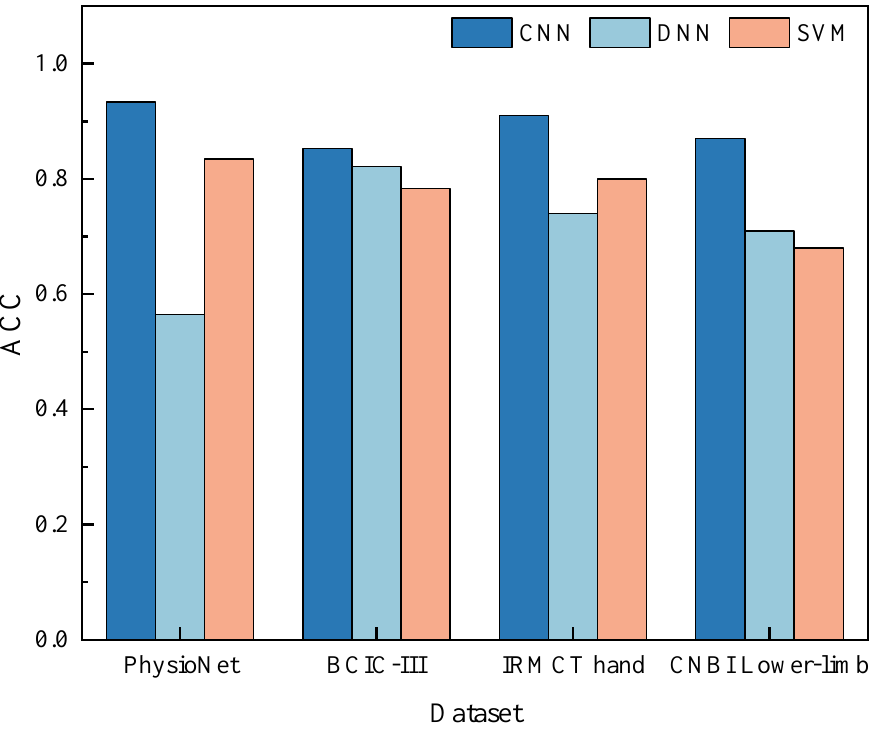
Figure 5. The classification accuracy (ACC) of the three decoding frameworks over the four datasets. For the second dataset, the mean ACC of the CNN, DNN and SVM-based meth- ods were 85.32 ± 3.00%, 82.15 ± 7.20% , and 78.62 ± 8.17%. No statistically significant differences were found by the repeated measures ANOVA ( p > 0.05) on the